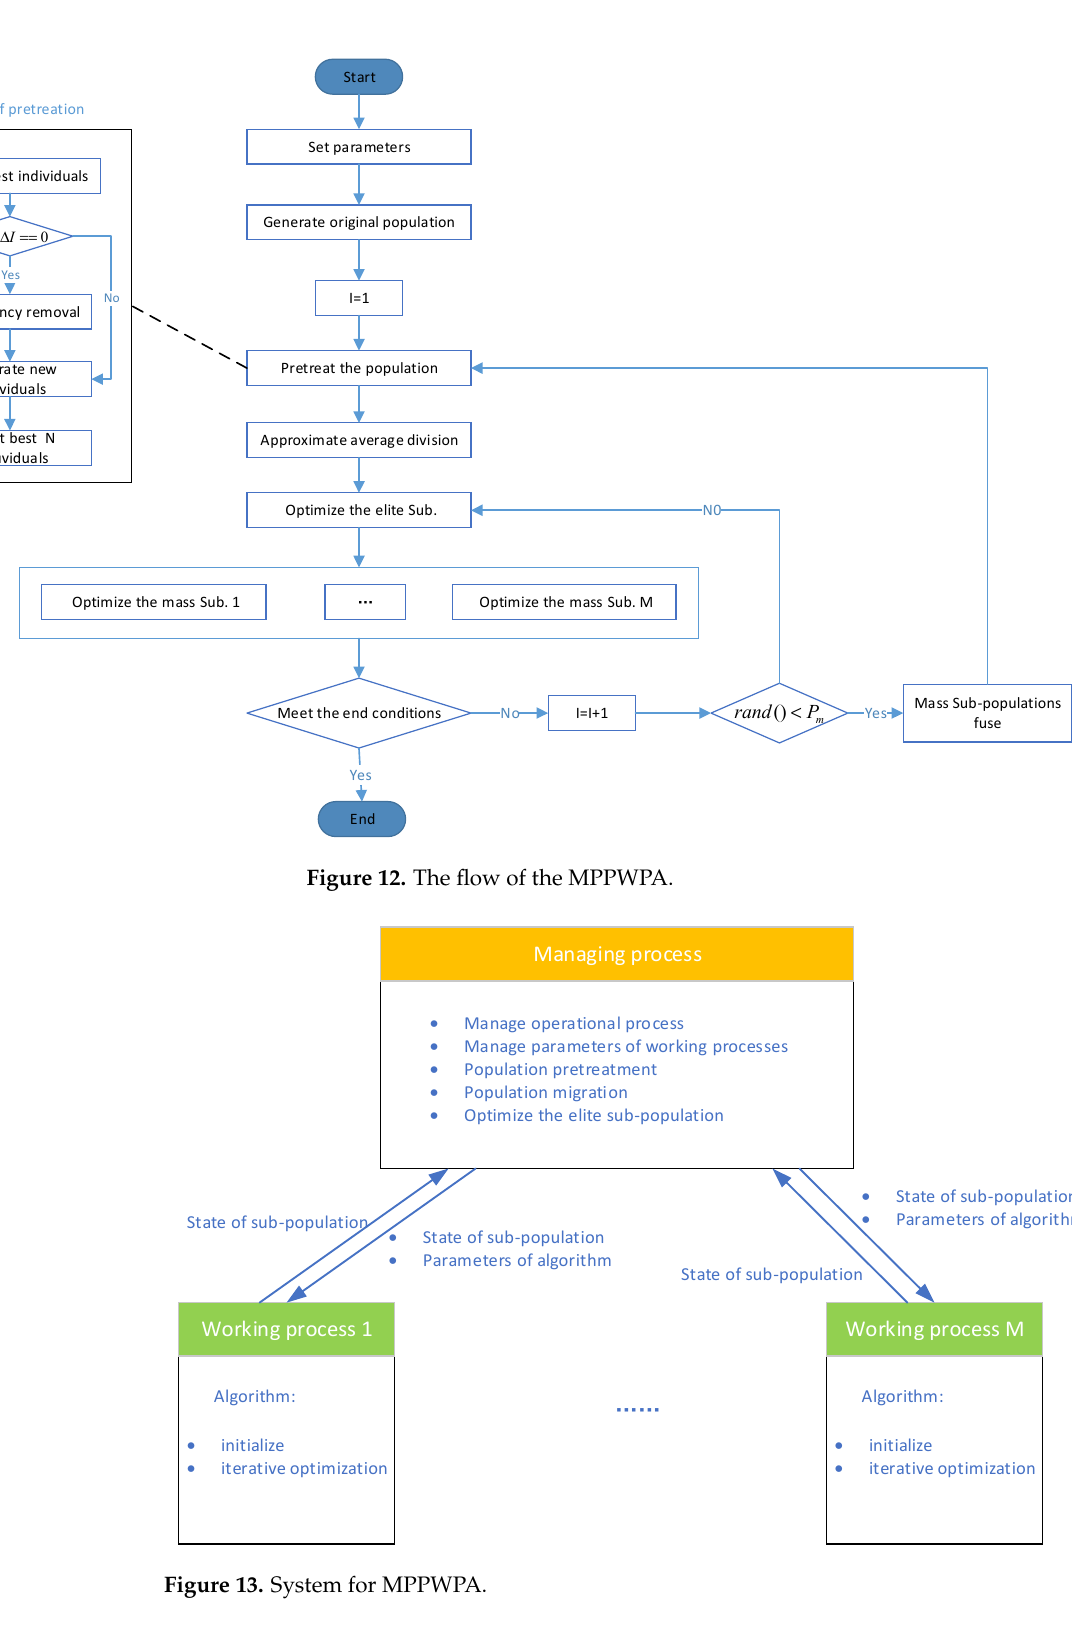
Figure 13. System for MPPWPA.